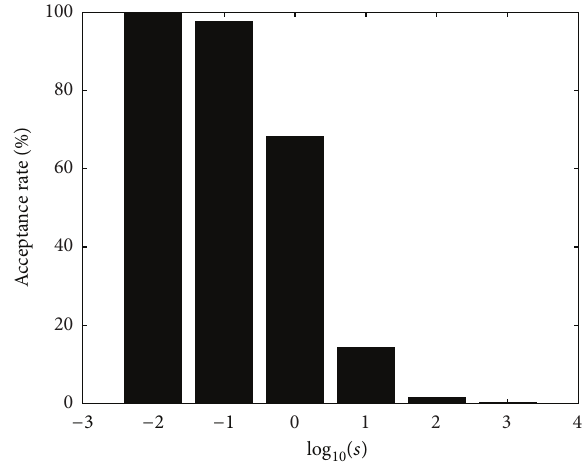
Figure5:Analysisofacceptanceratefor1-dimensionalMonteCarlo Markovian algorithm for different 𝑠